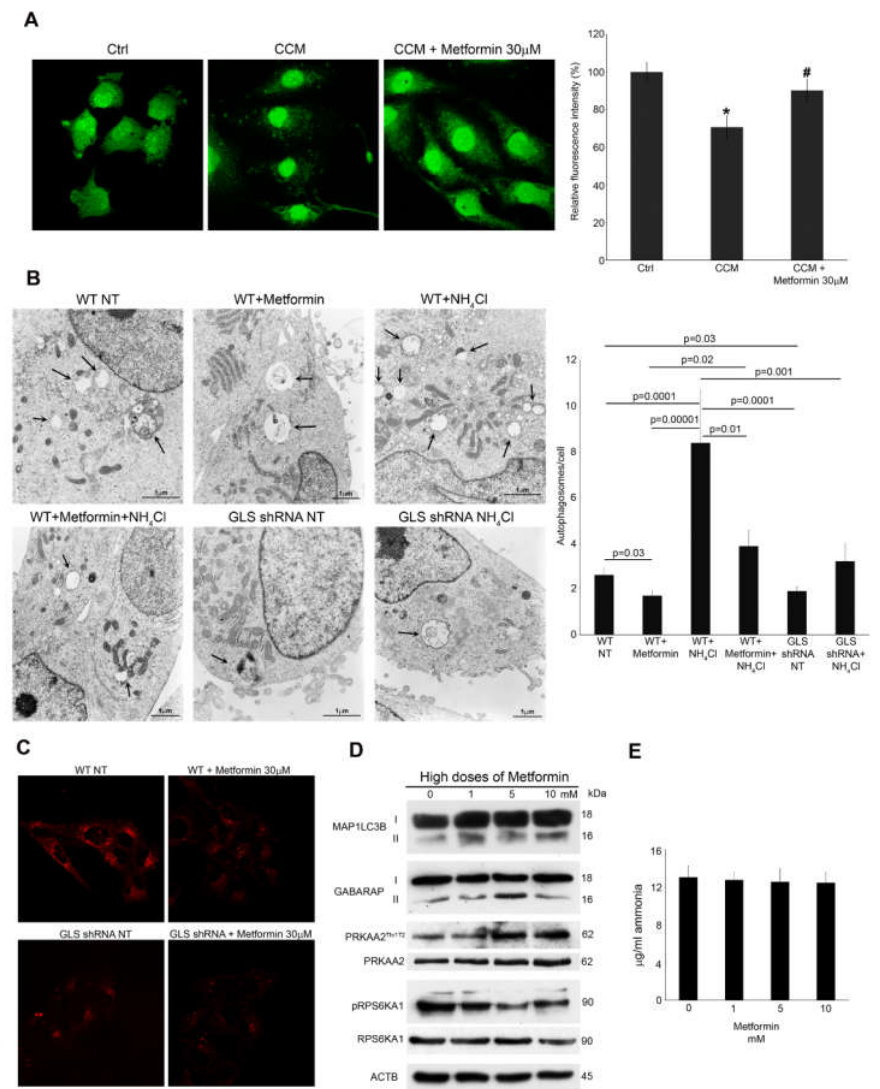
Figure 5. Metformin or GLS silencing reduces autophagosomes formation; ( A ) MDA-MB-231 cells (CCM) were plated in conditioned medium from CAM cells as described in Figure 4D for 48 h to stimulate autophagy in the presence or absence of metformin. At the same time MDA-MB-231 control cells (Ctrl) were plated in fresh medium for 48 h. At the end of the treatments, both Ctrl and CCM cells were labelled with AHA as described under Material and Methods. Cells were then fixed, permeabilized and stained for 2 h with alkine-Alexa Fluor 488. Fluorescence from long-lived proteins was observed using aLSM 510 confocal microscopy (Zeiss). MDA-MB-231 cells were placed in a 96 well plate, treated and labelled as described above. Right side: Fluorescence from long-lived protein was measured using a Glomax multidetection system (Promega). # Significantly different from CCM treated cells.; ( B ) MDA-MB-231 cells were either left untreated or treated with metformin 30 μM, NH 4 Cl 10 mM or a combination of the two. Alternatively, MDA-MB-231 GLS shRNA cells were left untreated or treated with NH 4 Cl 10mM. The cells were then processed for electron microscopy as described under Materials and Methods. Upper left: WT cells showing autophagosomes, (Magnification 15,500×). Upper middle: WT + metformin cells showing a lower number of autophagosomes (magnification 11,500×). Upper right: WT + NH 4 Cl cells showing an increase in autophagosomes (magnification 11,500×). Lower left: WT + metformin + NH 4 Cl cells showing a reduction in autophagosomes (magnification 11,500×). Lower middle: GLS shRNA cells showing a